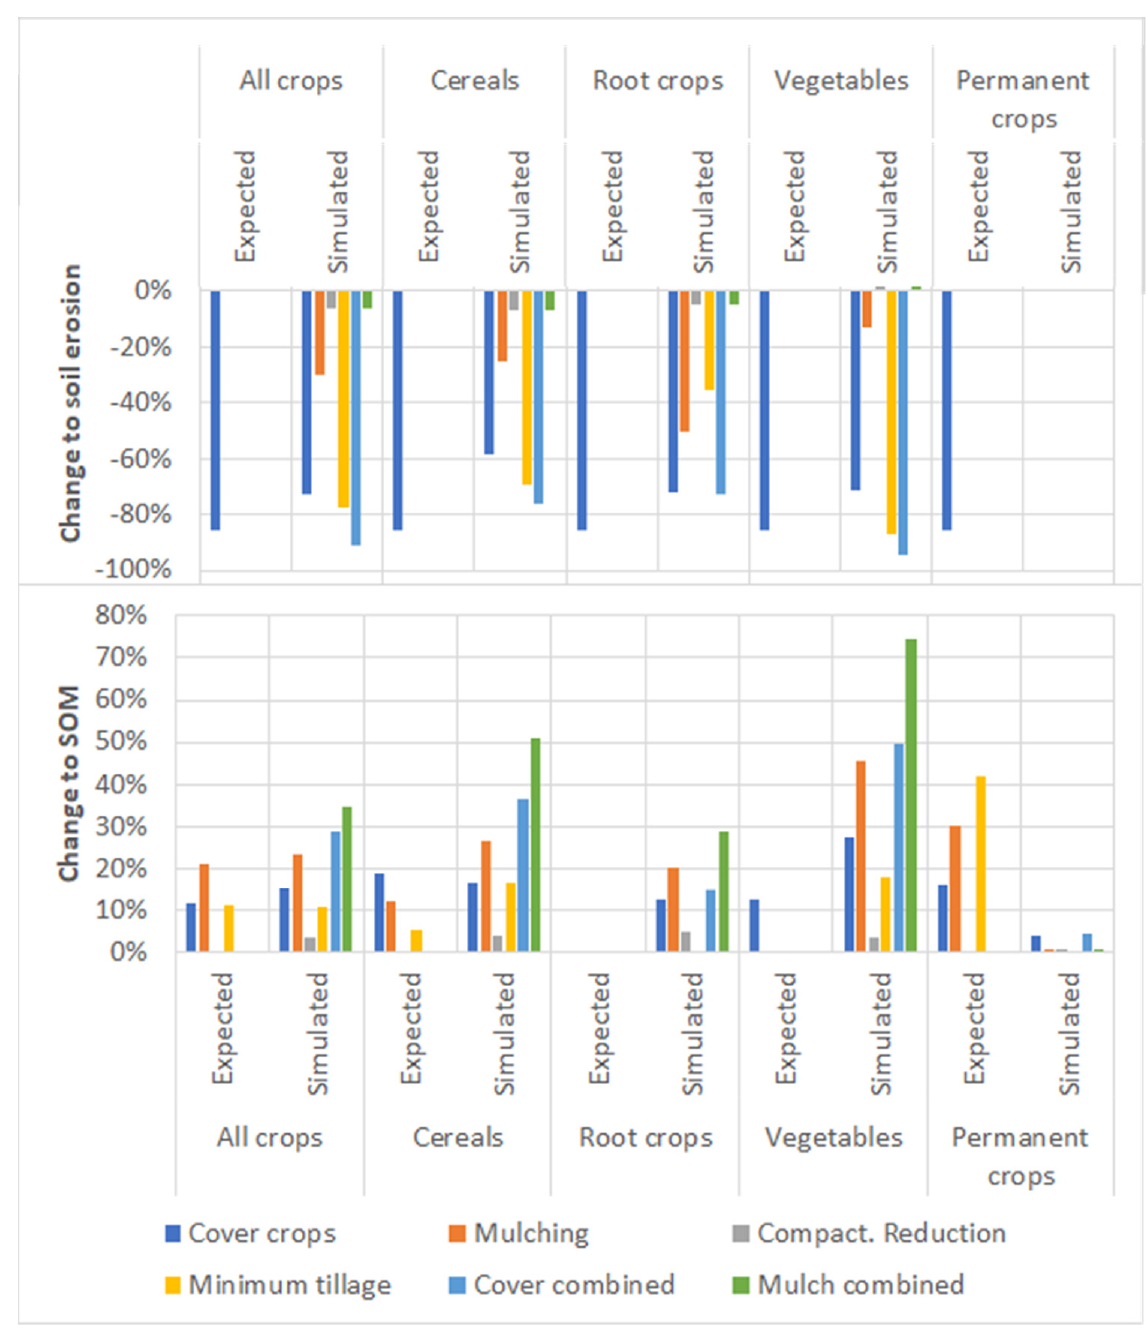
Figure 8. Impact of different SICS (expected; based on literature review, see Table S7, and simulated with PESERA on a test dataset) on different types of crops, for erosion ( top ) and soil organic matter ( bottom ).